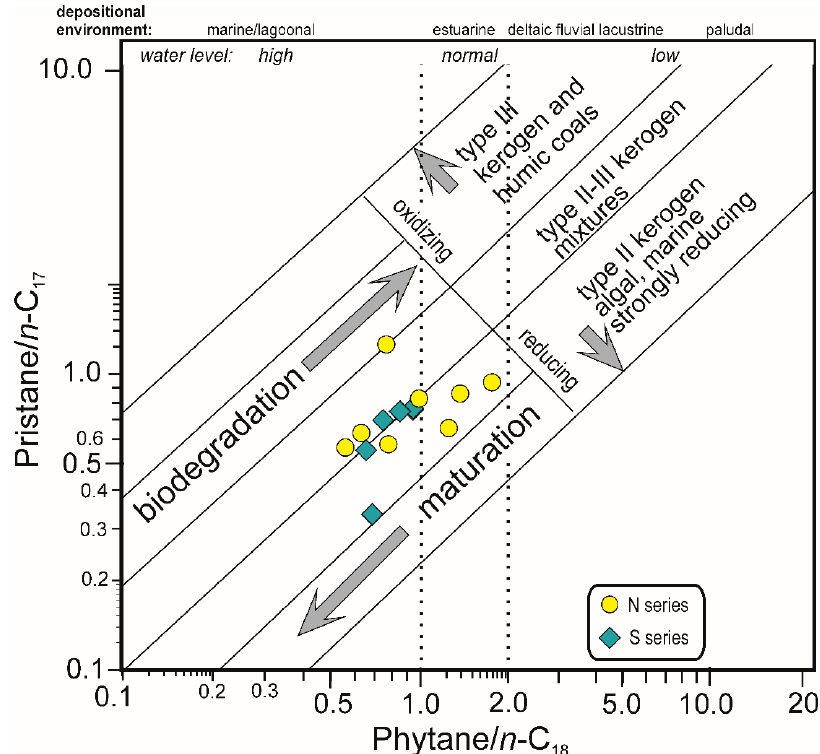
Figure 11. Pr/ n ‐ C 17 versus Ph/ n ‐ C 18 diagram. Pr, pristane; Ph, phytane. Figure 11. Pr/ n -C 17 versus Ph/ n -C 18 diagram. Pr, pristane; Ph, The n ‐ alkane ‐ and acyclic ‐ isoprenoid results seem to indicate more advanced = 217) and pentacyclic triterpanes ( m/z = 191) are compared. Excepting N6 and N7, these